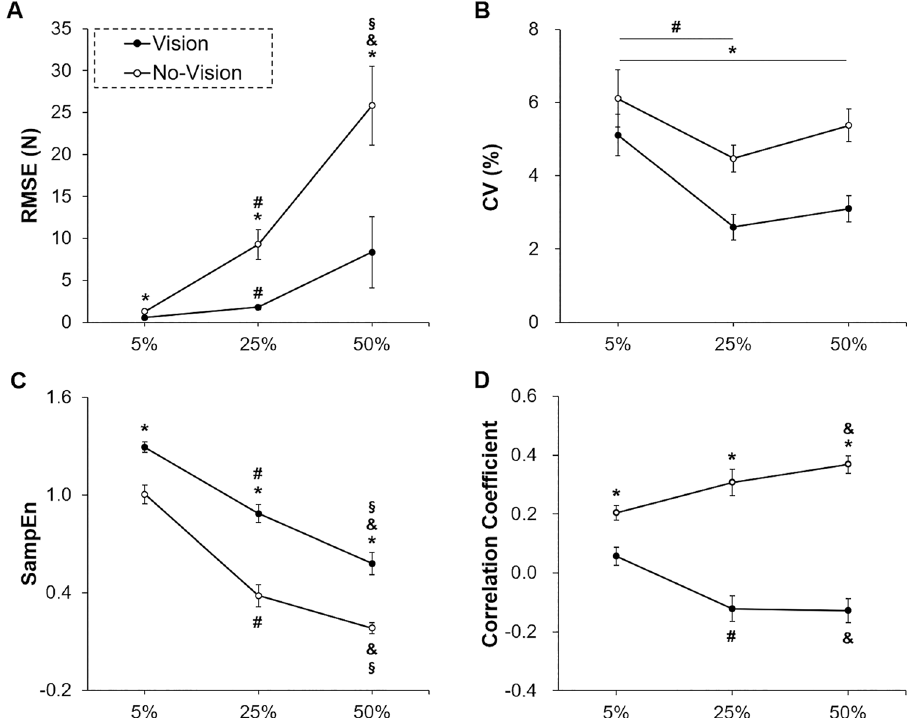
Figure 2. Bimanual force control performance within a trial ( M ± SE ). ( A ) Force accuracy (RMSE) showing a significant Visual Condition × Force Level interaction. ( B ) Force variability (CV) showing significant Visual Condition and Force Level main effects. ( C ) Force regularity (SampEn) showing a significant Visual Condition × Force Level interaction. ( D ) Correlation coefficients between hands showing a significant Visual Condition × Force Level interaction. Asterisk (*) denotes a significant difference between visual conditions. Number sign (#) indicates a significant difference between 5 and 25% of MVC. Ampersand (&) means a significant difference between 5 and 50% of MVC. Section sign (§) shows a significant difference between 25 and 50% of MVC .